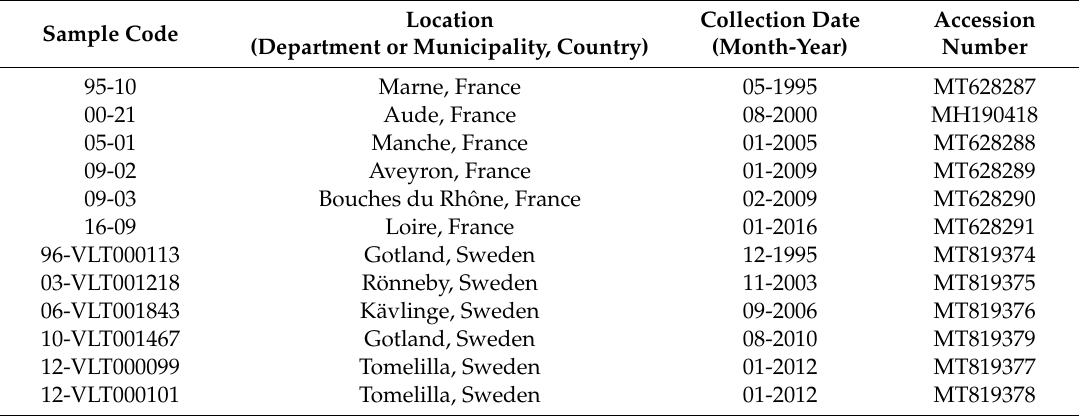
Table 1. Collection date and location of full genome sequences obtained in this